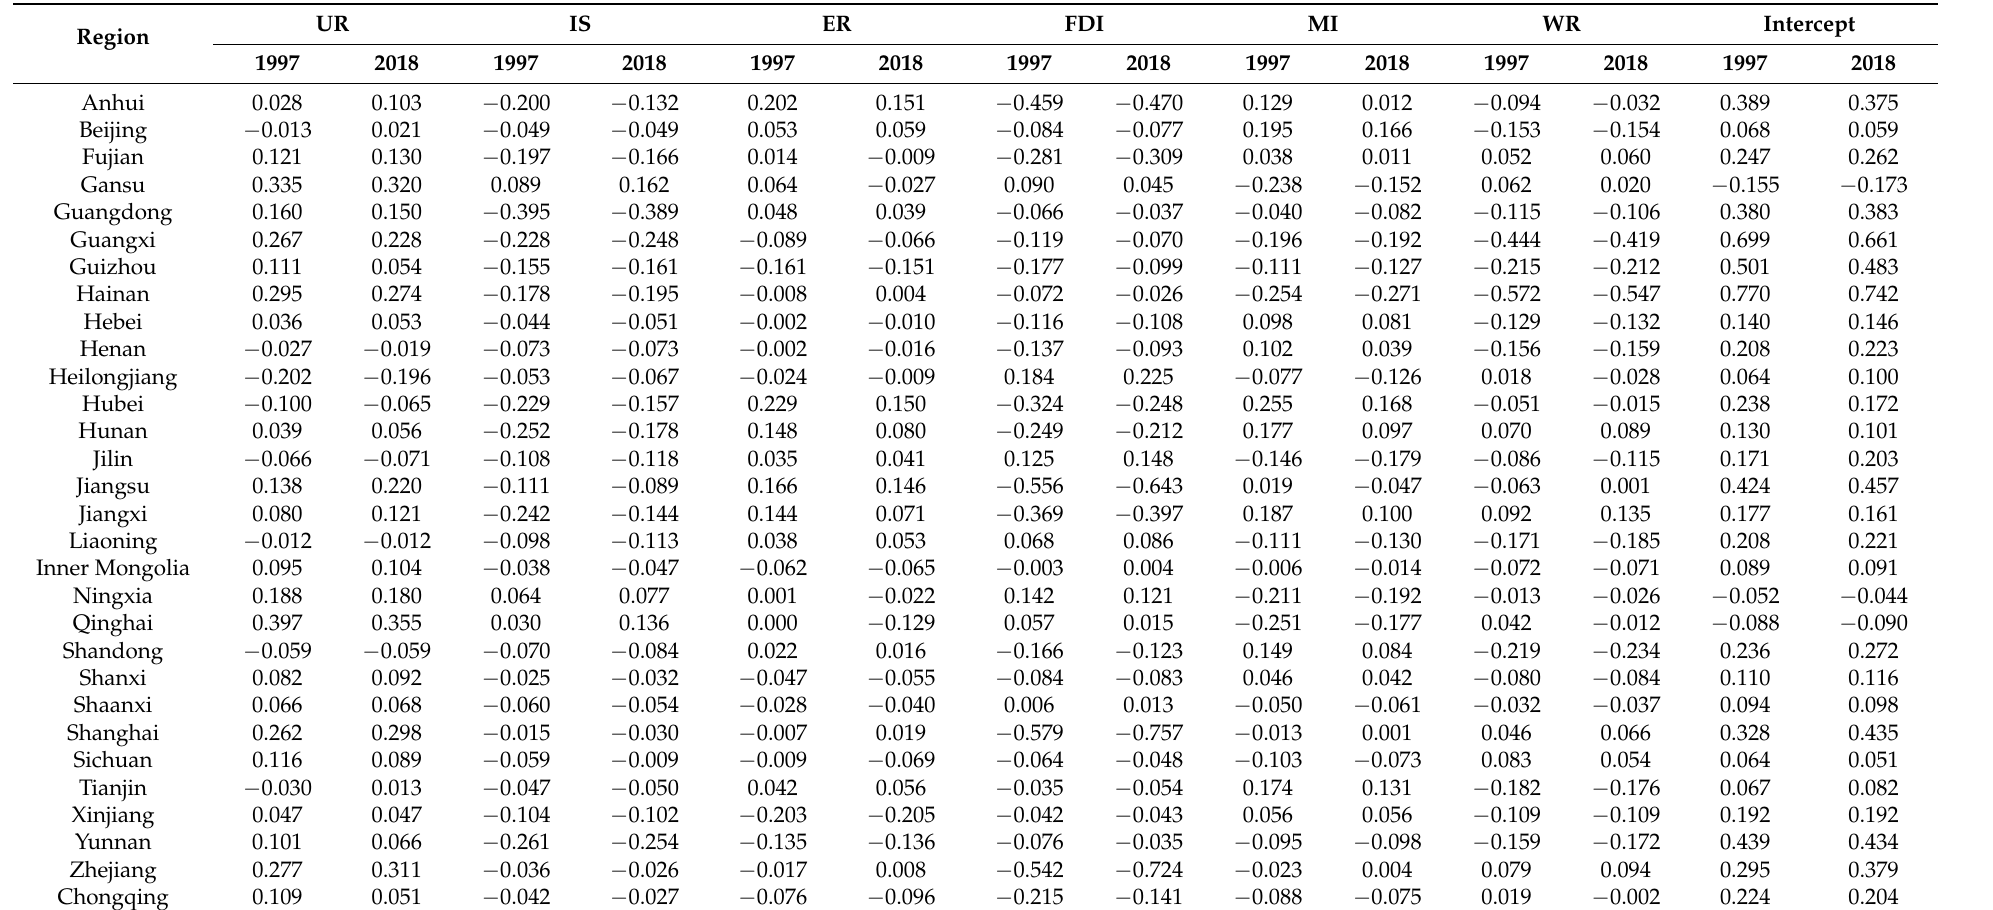
Table 9. GTWR results for 30 Chinese provinces in 1997 and